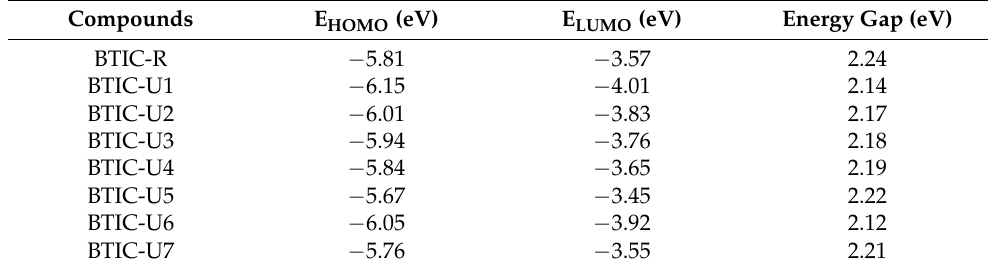
Table 1. Calculated energy gap ( E gap ) and FMOs (HOMO, LUMO) energy of BTIC-R and BTIC-U1 to